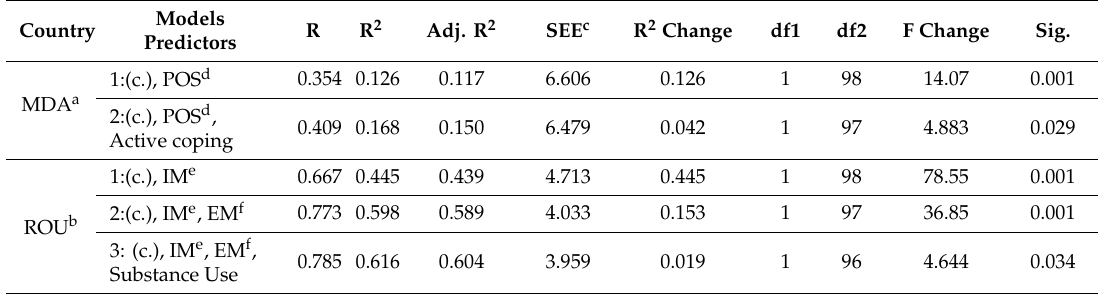
Table 3. Hierarchical linear regression models of emotional exhaustion in Moldova and